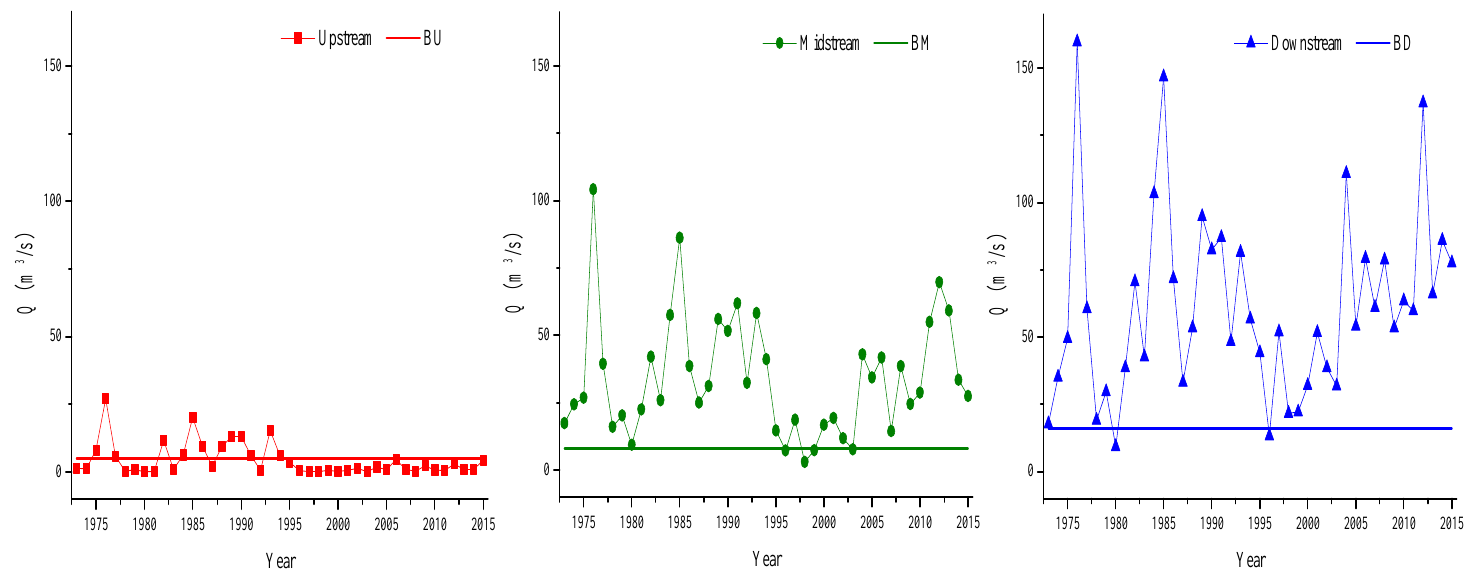
Figure 4. The measured data and baseline for EBF in the dry season at upstream, midstream and downstream sections of MSX from 1973 to 2015. “BU” represents the baseline of the upstream section (5 m 3 /s), “BM” represents the baseline of the midstream sections (8 m 3 /s), and “BD” represents the baseline of the downstream sections (16 m 3 /s). The measured data were provided by the Annual Hydrological Report of the People’s Republic of China (Yellow River Basin) , and the baseline data were from Table 4.